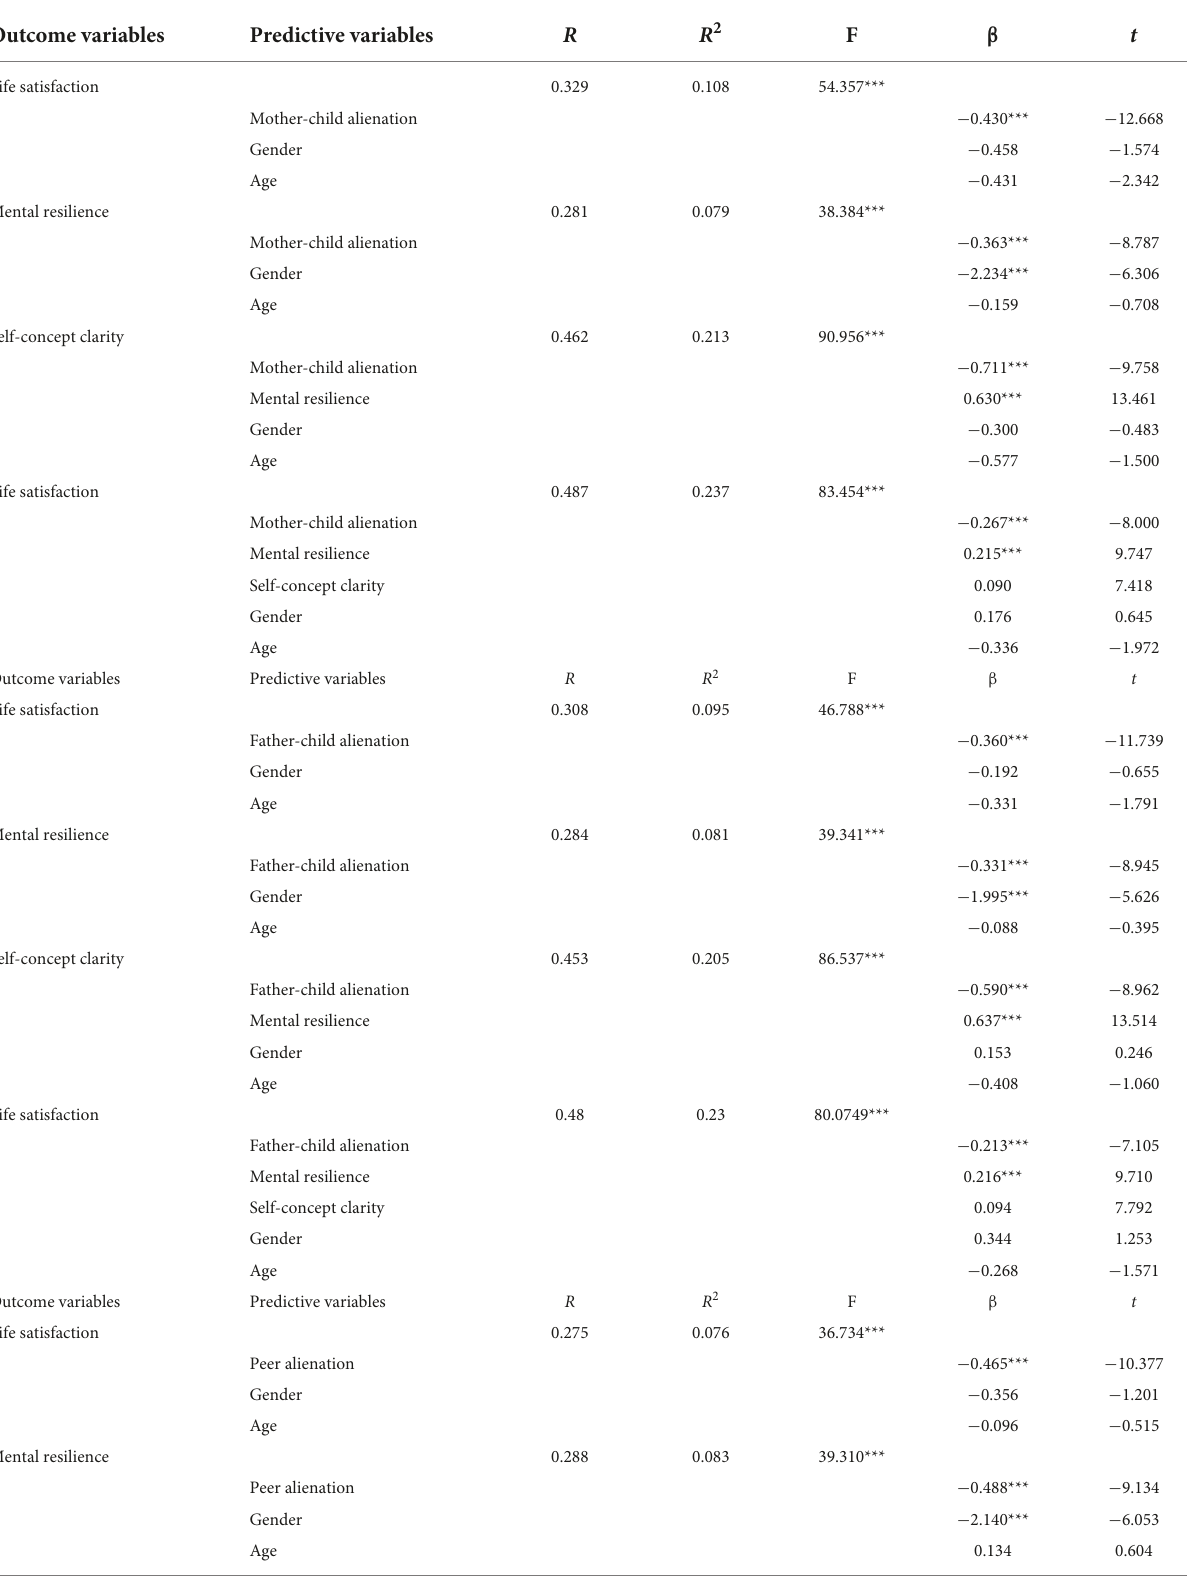
TABLE 3 The regression analysis among